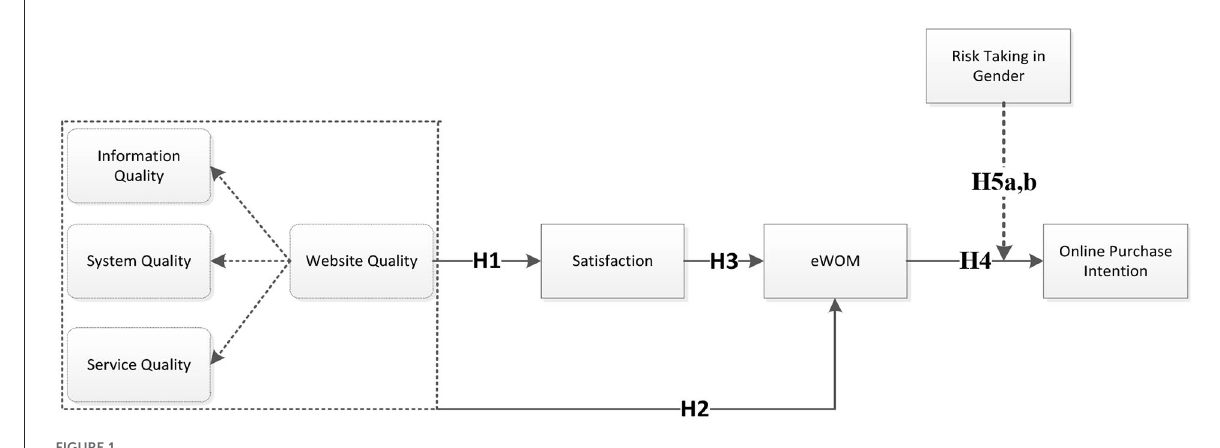
FIGURE1 Conceptual framework.